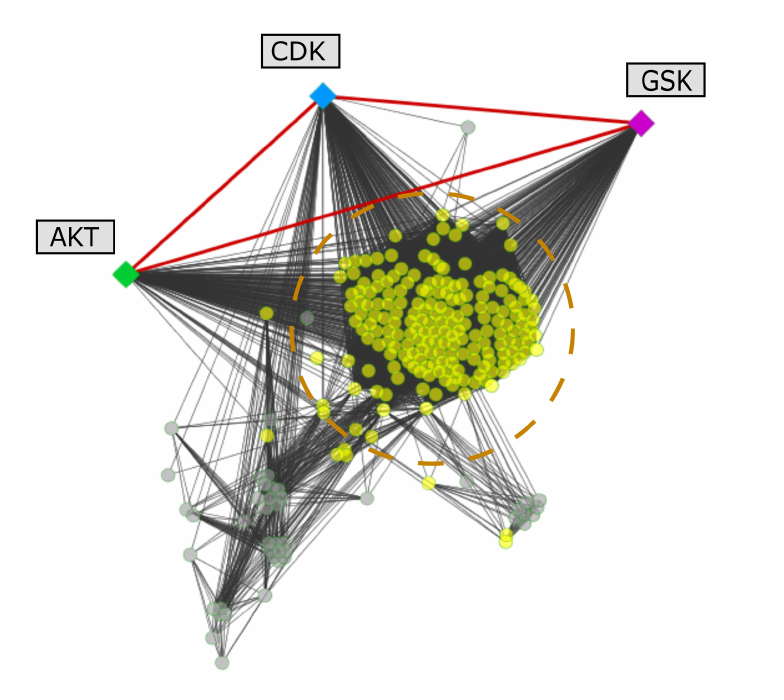
Figure 4. Visualization of the parasite-predicted PI3K-AKT pathway proteins, including the set of kinases, in the protein–protein interaction network of L. major . The kinases within the whole network are represented as cyan nodes, and Hsp90 members as red